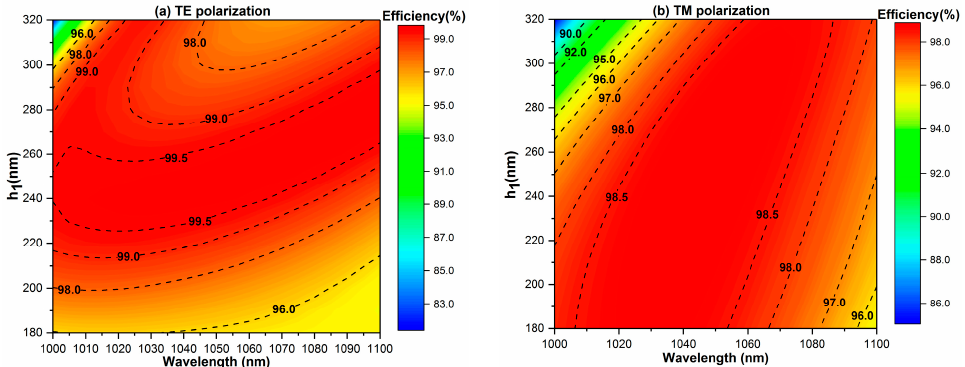
Figure 6. Tolerance analysis of the thickness of HfO 2 layer. − 1st order diffraction efficiency versus incident wavelength and h 1 for ( a ) TE and ( b ) TM